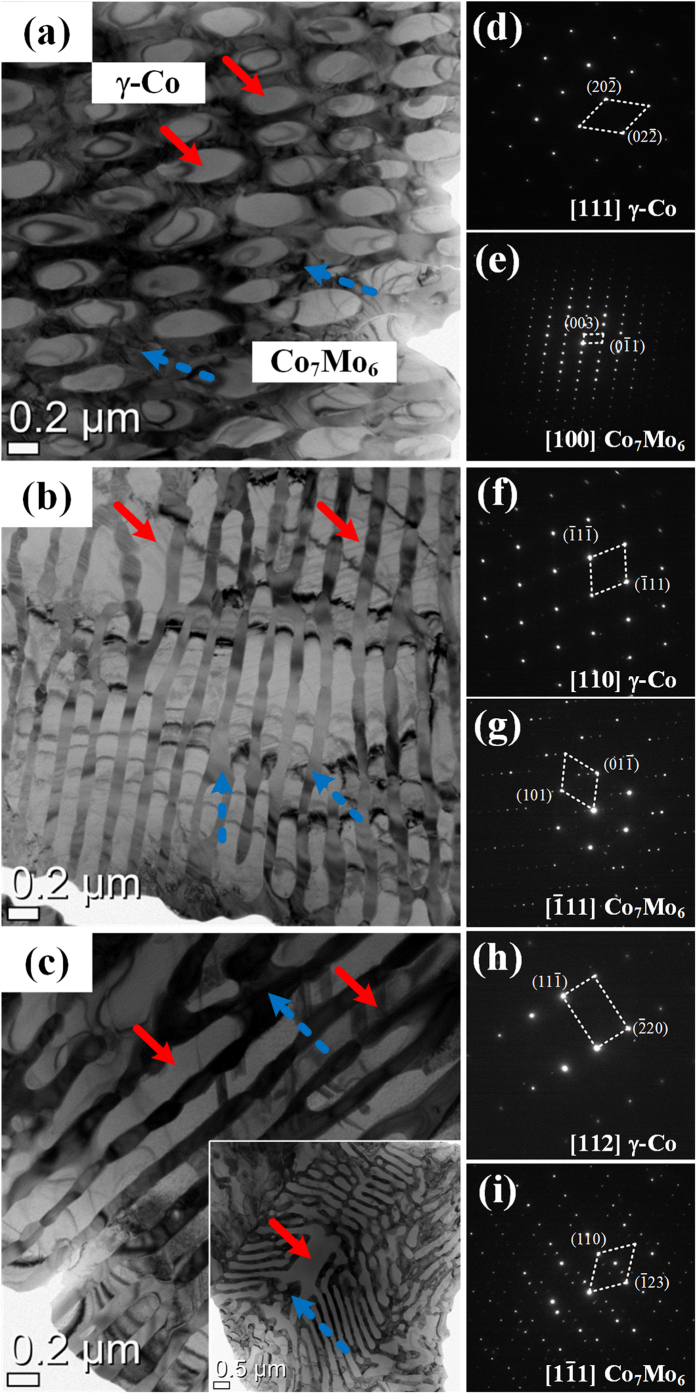
TEM bright-field (BF) images and elected area electron diffraction (SAED) patterns obtained from the as-cast Co65−xCr13Mo22Cux alloys with x = 0, 0.5 and 1 at.%: (a) BF image, (d–e) SAED patterns of x = 0 at.%, (b) BF image, (f–g) SAED patterns of x = 0.5 at.% and (c) BF image, and (h–i) SAED patterns of x = 1 at.%.